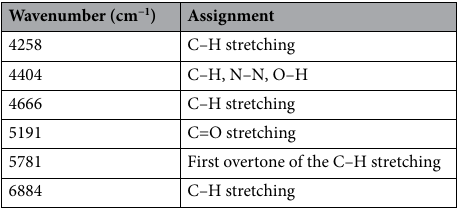
Table 2. Spectral peaks with assignment of their corresponding biochemical components.